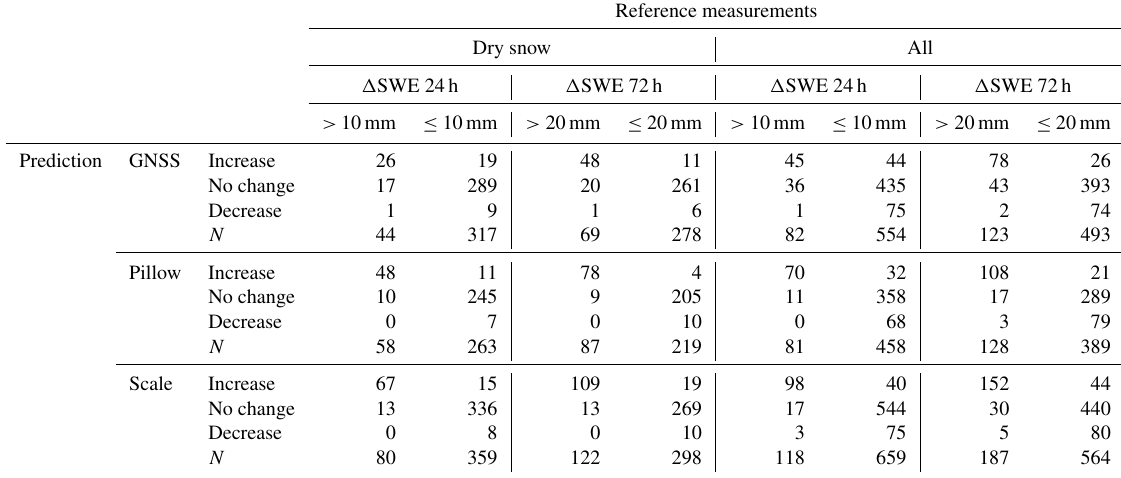
Table 3. Contingency table illustrating the detection performance of new snow events for GNSS (all sites, winter 2019–2020), snow pillow (Weissfluhjoch, 2018–2019 and 2019–2020) and snow scale (Weissfluhjoch and Laret, 2018–2019 and 2019–2020). We considered new snow days with an increase in (cid:49) SWE ref larger than 10mm in the preceding 24h or larger than 20mm in the preceding 72h. For (cid:49) SWE from GNSS, pillow and scale we defined three classes: (1) days with an increase if (cid:49) SWE > 10mm over 24h, (2) days with no change if | (cid:49) SWE | ≤ 10mm and (3) days with a decrease if (cid:49) SWE < − 10mm. For (cid:49) SWE over 72h we used ± 20mm as the threshold. N is the total number of days